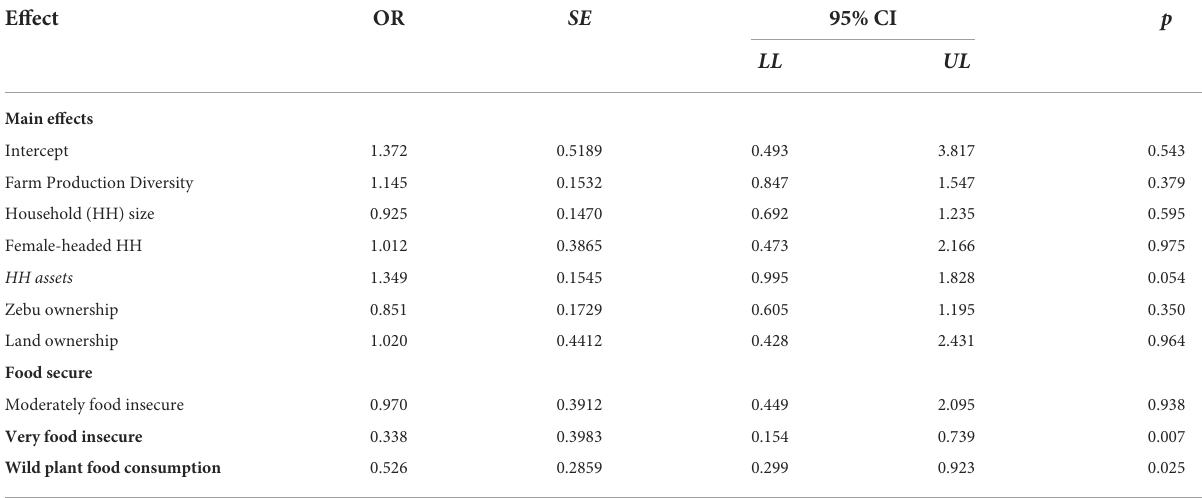
TABLE 5 Main effects from multilevel mixed effects Model 1.